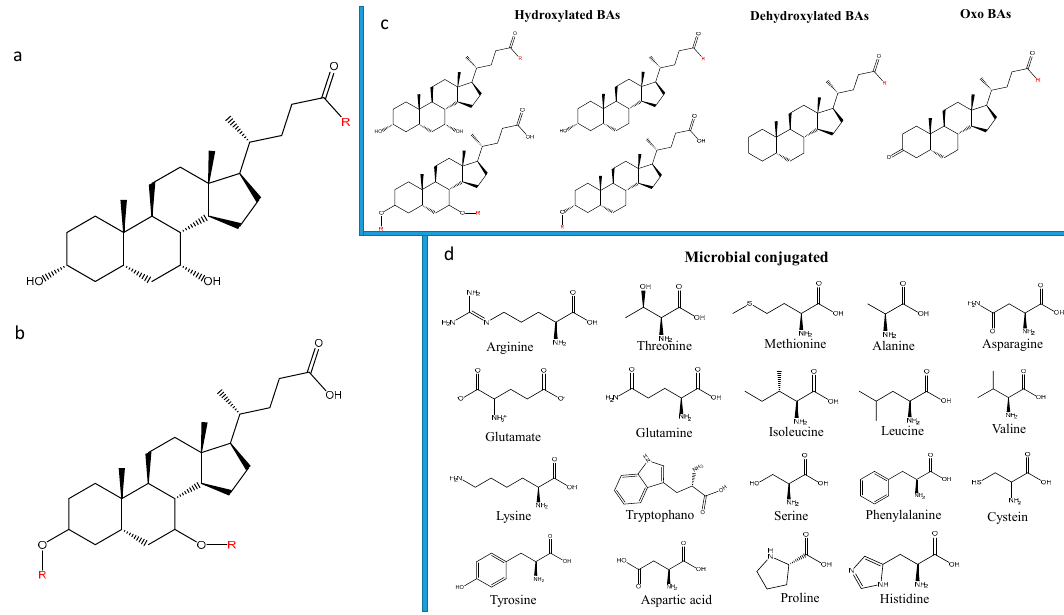
Figure 3. Conversion possibilities of microbially conjugated BAs by the human gut microbiota. ( a ) Position possibilities for the amino acid along the cholic acid backbone; ( b ) Position possibilities for the amino acid along the cholic acid backbone in case of esterification reaction; ( c ) Position possibilities for the amino acid in case of hydroxylated, dehydroxylated and oxidized BAs; ( d ) Amino acid used to cover the conjugation possibilities.